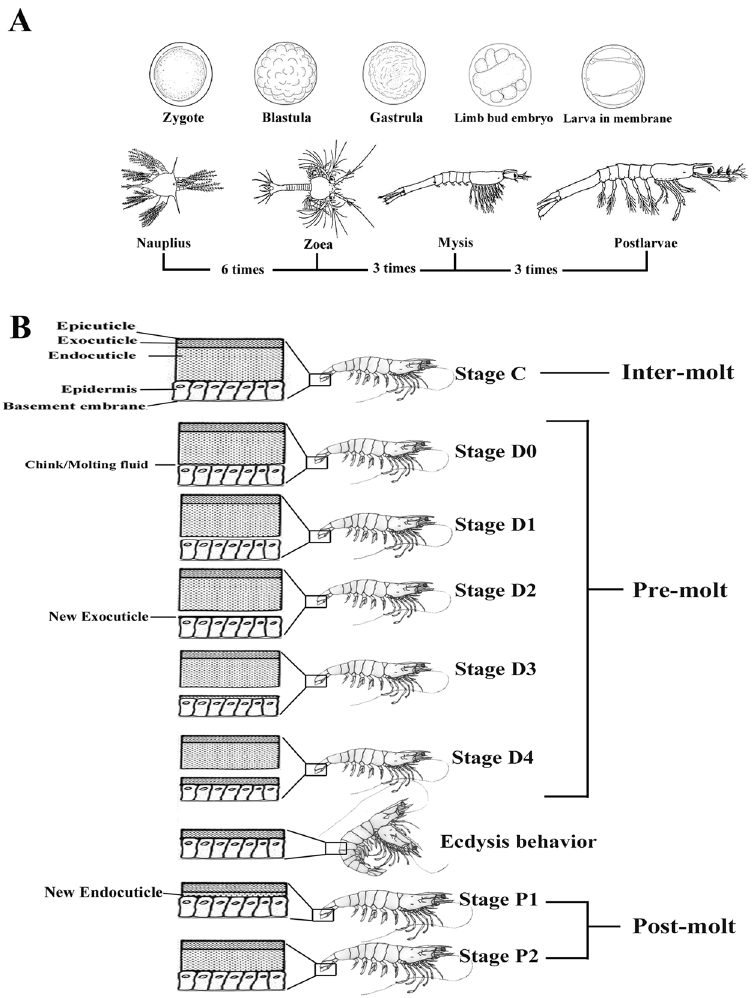
Figure 1. ( A ) Embryonic and larval stages during early development of L. vannamei . Morphologies are modified from Wei, etc , 2014 19 . The moulting times are labelled under the figure. ( B ) Hierarchical structure of the exoskeleton of L. vannamei during the moulting